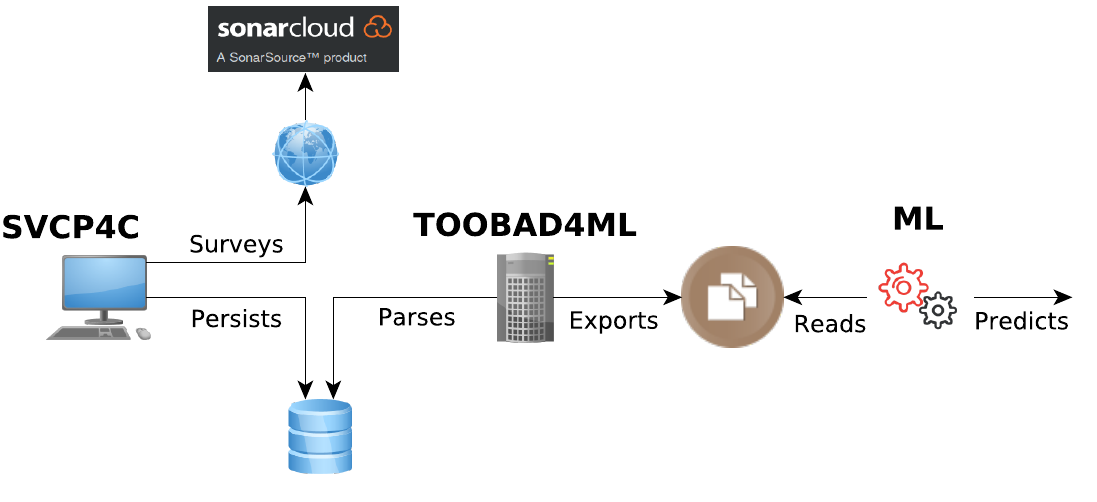
Figure 1. TOOBAD4ML’s conceptual